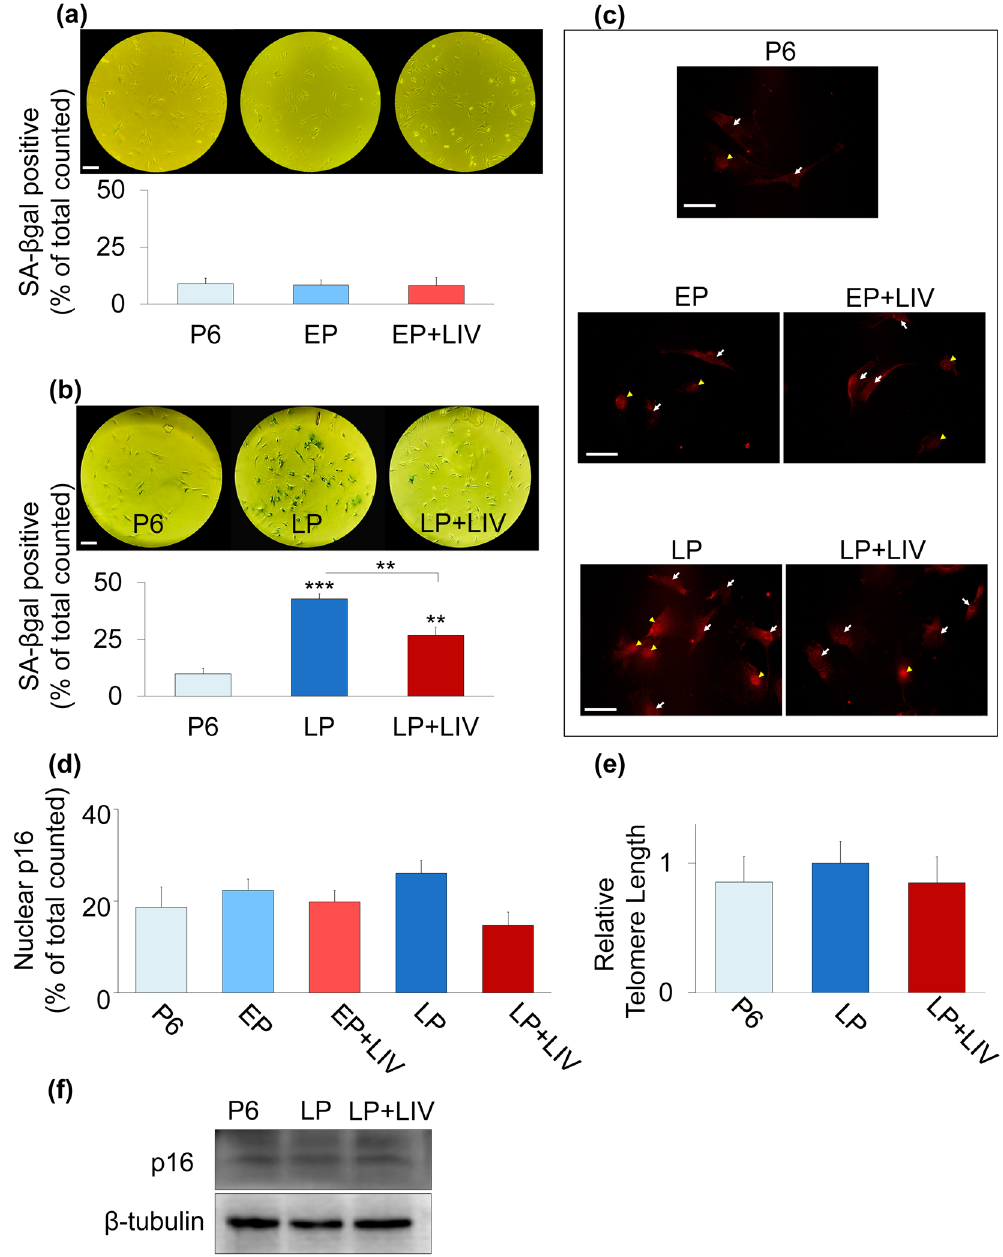
Figure 3. LIV In vitro expansion and LIV alters β -galactosidase activity but not p16 levels and telomere length in MSCs. ( a ) SA- β gal experiments at EP and LP time points were run, stained and analyzed independently. 8% of P6 MSCs were identified as SA- β gal positive and neither the EP nor EP + LIV groups showed any significant change compared to P6. ( b ) The P6 group was 9.8% SA- β gal positive, 42.8% of cells in LP group were identified as SA- β gal positive (P < 0.001) and this was decreased to 26.8% in LP + LIV group. Percentage of SA- β gal positive cells in + LIV group was significantly lower when compared to LP (p < 0.01) but remained significantly elevated compared to P6 (p < 0.01). ( c ) Immunolabeling against p16 was visible in cytoplasm (white arrows) and in the nuclei (yellow arrowheads). ( d ) Quantification of p16 positive nuclei showed no differences between groups. ( e ) There was no measurable difference between telomere lengths of P6, LP and LP + LIV groups and ( f ) western blotting of p16 protein also showed no difference between P6, LP and LP + LIV MSCs. Full-length blots are presented in Supplementary Fig.S2. Scale bar: 100 µ m. n = 3/grp, group comparisons were made using one-way ANOVA followed by a Newman-Keuls post-hoc test ( a , b , e , f ) or Kruskal-Wallis test followed by Dunn’s multiple comparison test ( d ). p < 0.05, ** p < 0.01, *** p < 0.001, against control and each